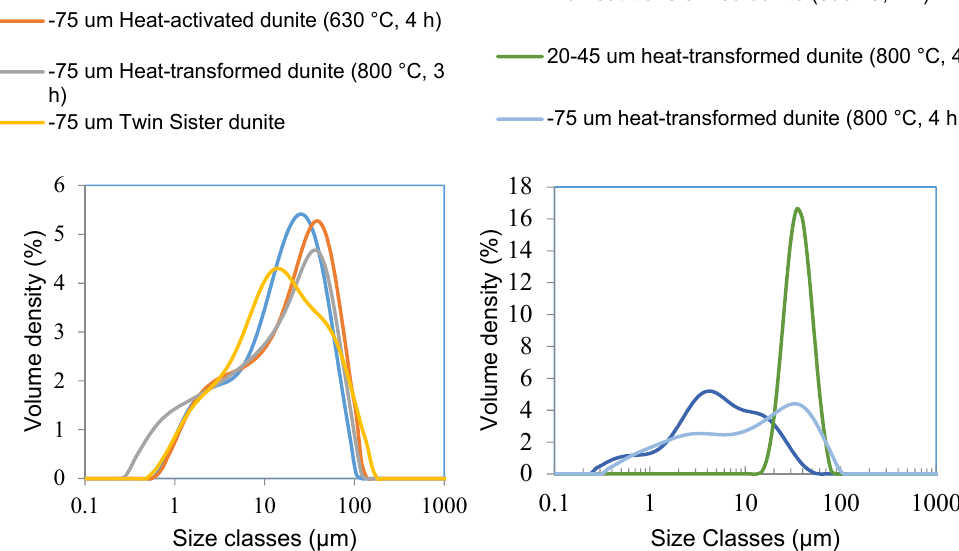
Figure 10. Particle size distribution (PSD) for sub-75 µm fractions of raw dunite, heat-activated dunite (630 °C, 4 h), heat-transformed dunite (800 °C, 3 h), and twin sister dunite (left), PSD for sub-75 µm fraction, sub-20 µm fraction, and 20–45 µm fraction of heat-transformed dunite (800 °C, 4 h) (right).